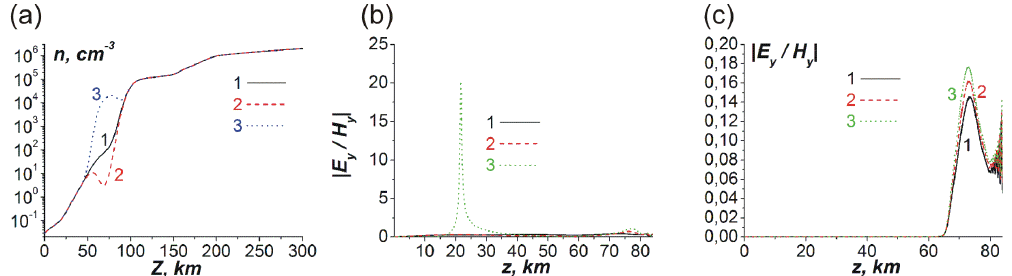
Figure 9. (a) Decreased and increased electron concentration (line 2, red) and (line 3, blue) correspond to f 00 = − 1 . 25 and f 00 = 250, respectively, relative to the reference concentration (line 1, black) with parametrization conditions (see Eq. 35) z 1 = 50km, z 2 = 90km and (cid:49) = 20km. Panels (b) and (c) are the polarization parameter | E y /H y | altitude distribution for decreased and increased electron concentra- tion, respectively. In (b) and (c) lines 1, 2 and 3 correspond to ω values 0 . 86 × 10 5 s − 1 , 1 . 0 × 10 5 s − 1 and 1 . 14 × 10 5 s − 1 , respectively. Angle θ is equal to 45 ◦